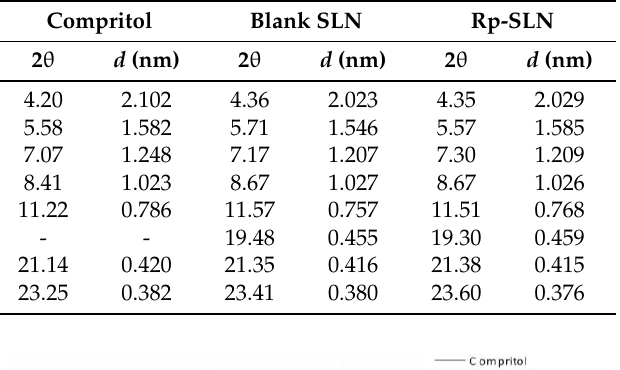
Table 3. Wide angle X-ray scattering (WAXS) main peak signals and Bragg’s lattice spacings for blank and Rp-SLN in comparison with bulk compritol. Compritol Blank SLN